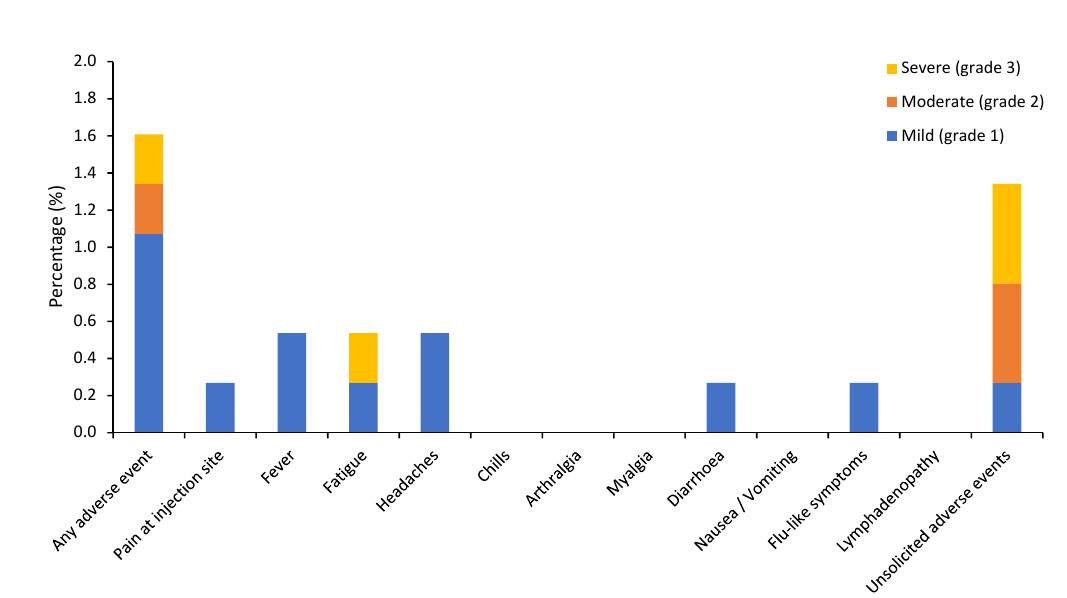
Figure 2. Vaccine-related adverse events after 7 days post-vaccination. Four grade 3 adverse events occurred that required hospital admission. One patient with breast cancer on hormone therapy developed grade 3 transaminitis with liver capsule pain from suspected reactivation of hepatitis B. One patient developed grade 3 diarrhoea and urosepsis 12 h post-vaccination. One patient with locally advanced breast cancer developed febrile neutropaenia on day 9 post-chemotherapy, the fever of which was likely vaccine-related with no evidence of infection. Finally, one patient with metastatic bladder cancer developed recurrent pulmonary embolism 2 weeks post-vaccination (Pfizer/BioNTech), likely related to multiple risk factors including dehydration and reduced mobility from grade 3 flu-like symptoms, and fatigue and interruption in anticoagulation therapy due to haematuria. There was no incidence of vaccine-induced immune thrombotic thrombocytopaenia in our total cohort. Of the total cohort, 349 patients were included for further analysis with respect to individual risk factors and vaccine reactogenicity (Tables 5–7). We excluded patients with haematological malignancies ( n = 19) and incomplete datasets ( n = 6, missing data for BMI). Individuals were analysed for their risk of developing total any grade vaccine-related adverse events, grade ≥ 2 adverse events, and any grade systemic adverse events. Male pa- tients were less likely to report any vaccine-related adverse events compared to females (OR 0.426 [95%CI 0.259–0.699]; p = <0.001). Patients receiving immunotherapy within 6 months of vaccination appear to be at a lower risk of developing any vaccine-related adverse events as well (OR 0.495 [95%CI 0.256–0.958]; p = 0.0037). Age ≥ 55, BMI ≥ 30, presence of 1 or more comorbidities, prior COVID-19 infection, having metastatic cancer, receiving chemotherapy during time of vaccination, and receiving the Pfizer/BioNTech vaccine (compared to Oxford/AstraZeneca) did not influence risk of developing any grade adverse events. With regards to developing grade ≥ 2 adverse events, older patients ( ≥ 55 years old) (OR 0.481 [95%CI 0.237–0.974]; p = 0.042) and those receiving the Pfizer/BioNTech vaccine were at a lower risk but not statistically significant (OR 0.366 [95%CI 0.177–0.758]; p = 0.007). There was also a general trend towards lower incidence of grade ≥ 2 adverse events in patients with metastatic cancer (OR 0.493 [95%CI 0.238–1.021]; p = 0.057). Nega- being male (OR 0.632 [95%CI 0.400–0.999]; p = 0.049), having metastatic cancer (OR 0.548 [95%CI 0.347–0.867]; p = 0.010), receiving chemotherapy within 28 days of vaccination (OR 0.373 [95%CI 0.221–0.629]; p < 0.001), and receiving the Pfizer/BioNTech vaccine (OR 0.452 [95%CI 0.274–0.747]; p = 0.002). There was no association between prior COVID-19 infection (both suspected and confirmed) and risk of vaccine-related adverse